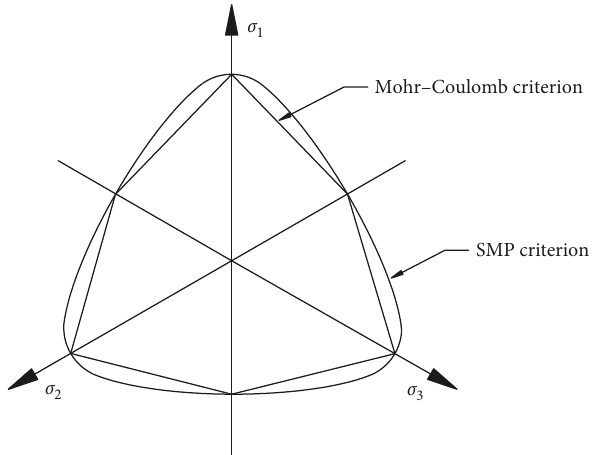
Figure 1: Mutual relationship between the Mohr–Coulomb cri- terion and SMP criterion in the π